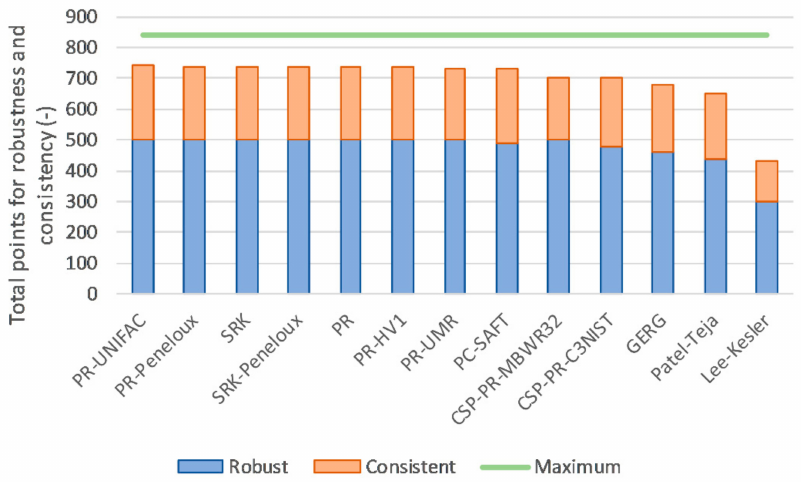
Figure 7. Scores for each EOS based on robustness and